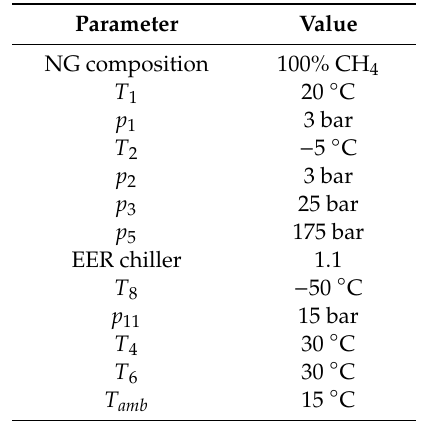
Table 3. Constant thermodynamic parameters for the design and o ff -design analysis (plant sections with reference to Figure